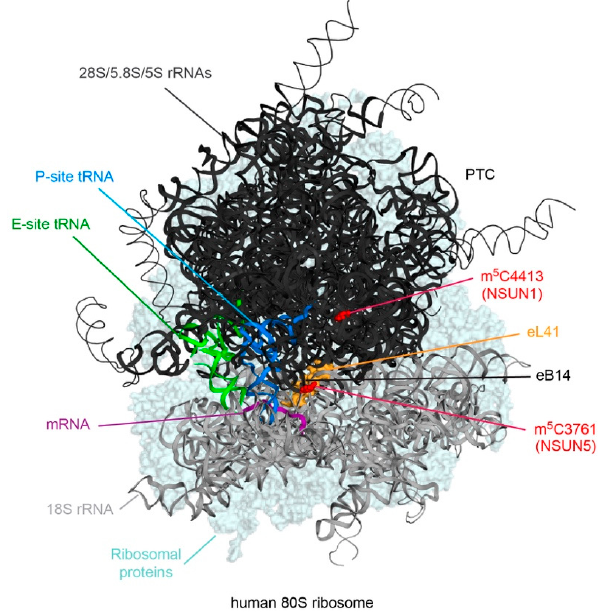
Figure 2. Schematic views of the positions of m 5 C modifications in cytoplasmic rRNAs. A cryo-EM